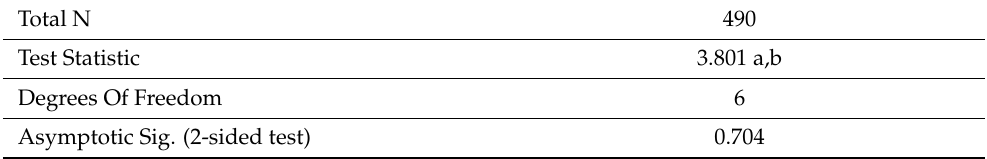
Table A7. Effects on response time (lateral thinking abilities).